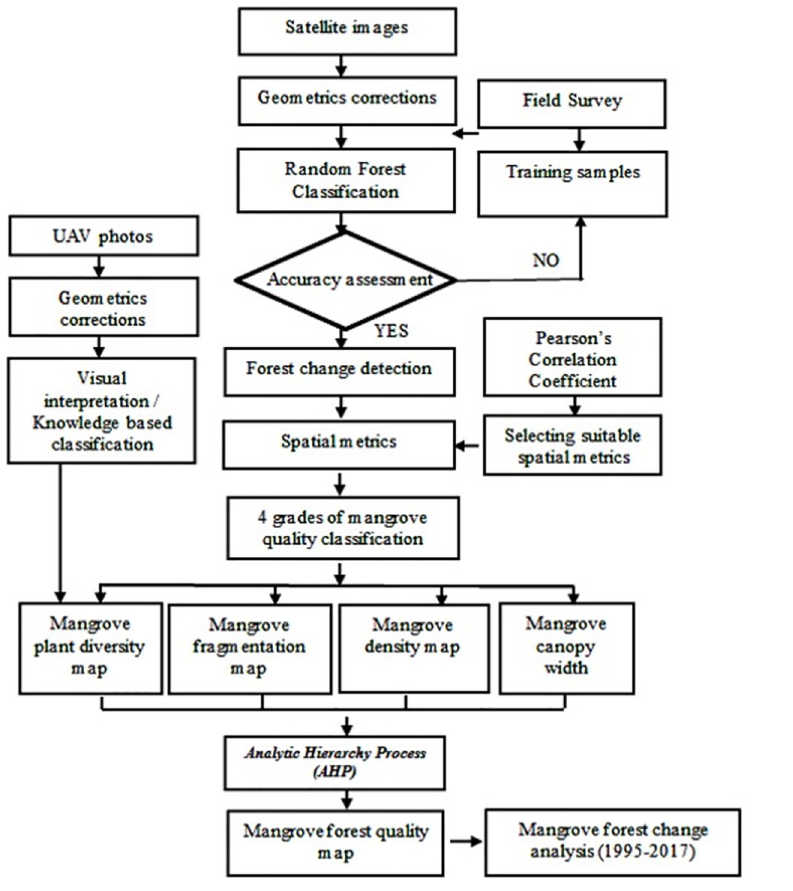
Fig 8. The flow chart developed in the